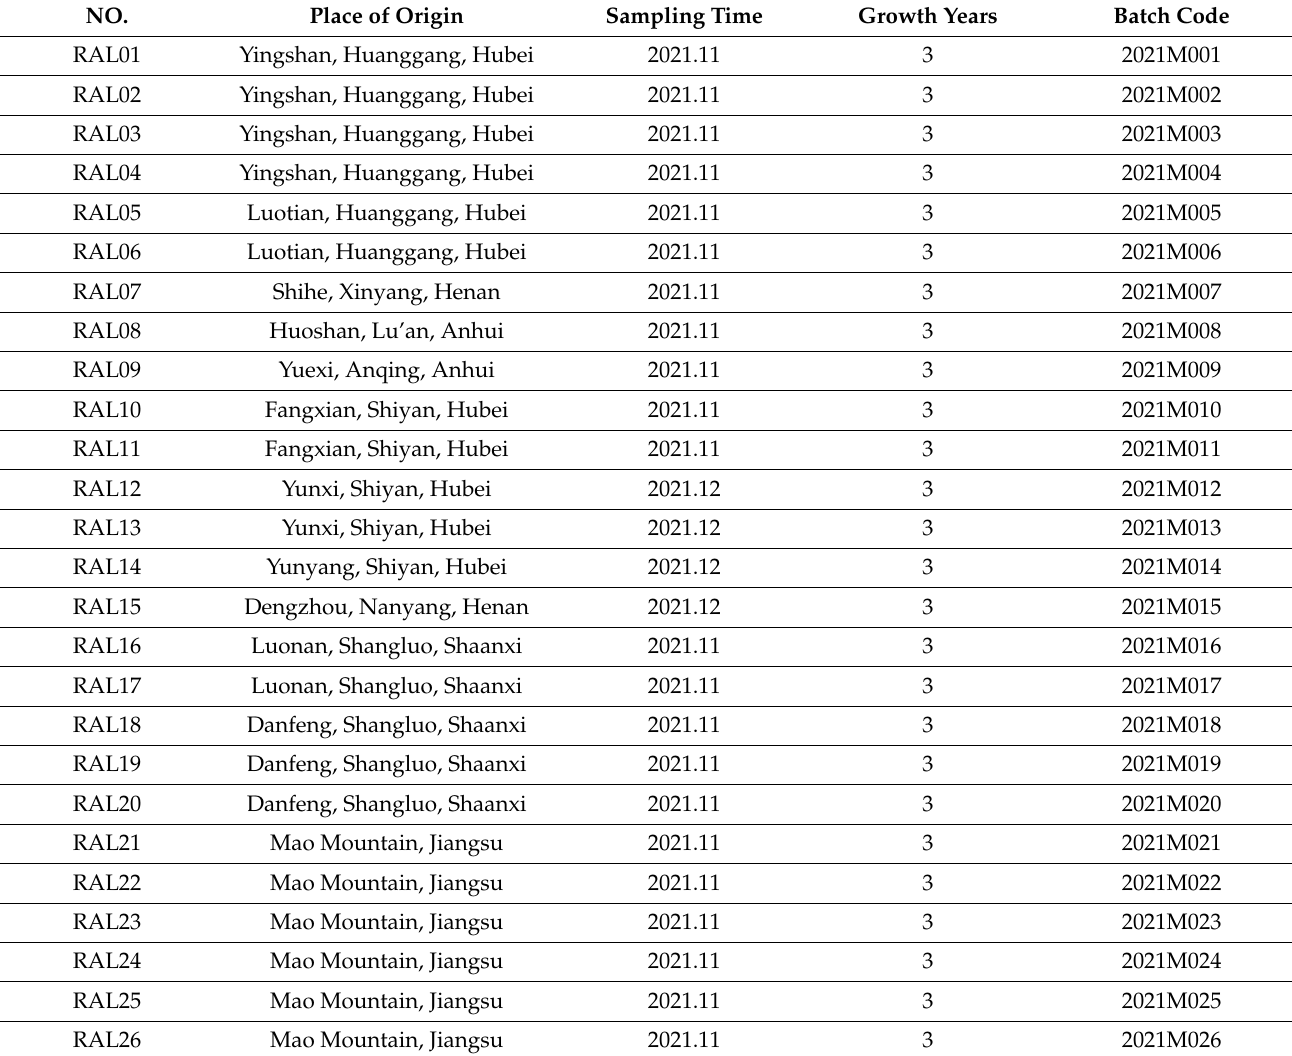
Table 1. Sample information of 26 batches of